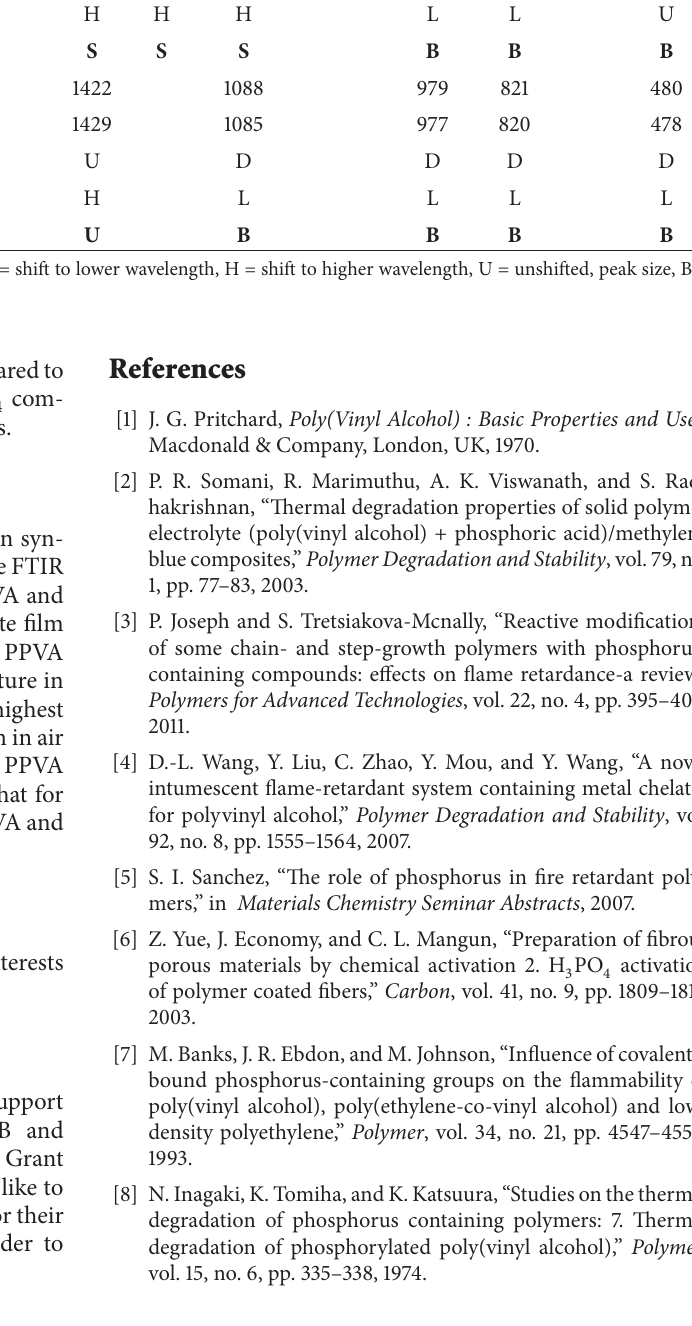
Table 2: Interpretation of PVA/PPVA and PPVA-ALPO